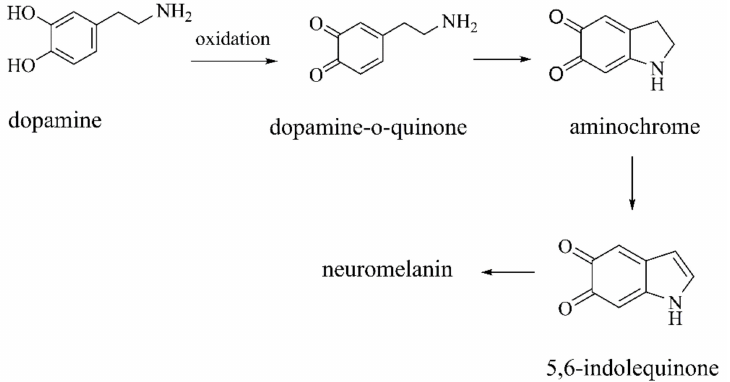
Figure 12. Dopamine spontaneously oxidization into neuromelanin